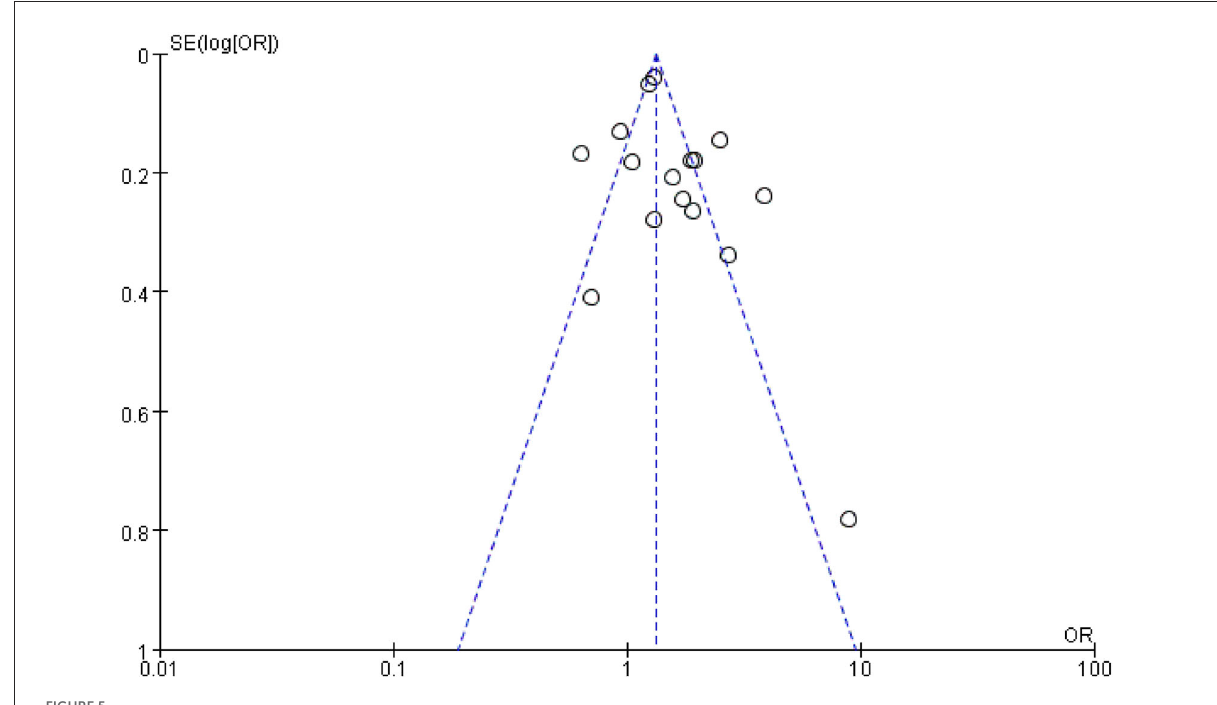
FIGURE5 Publication bias of